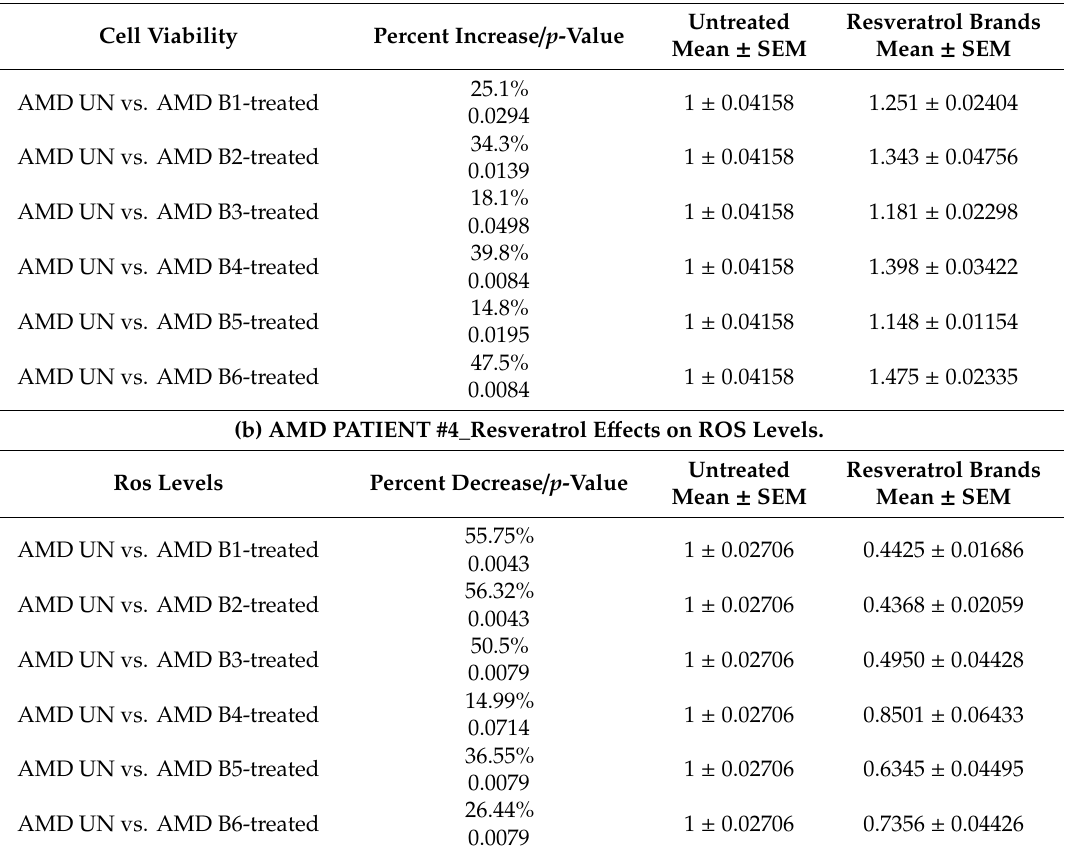
Table 6. E ff ects of resveratrol formulations on cell viability ( a ) and ROS levels ( b ) in AMD patient # 4. (a) AMD PATIENT #4_Resveratrol E ff ects on Cell